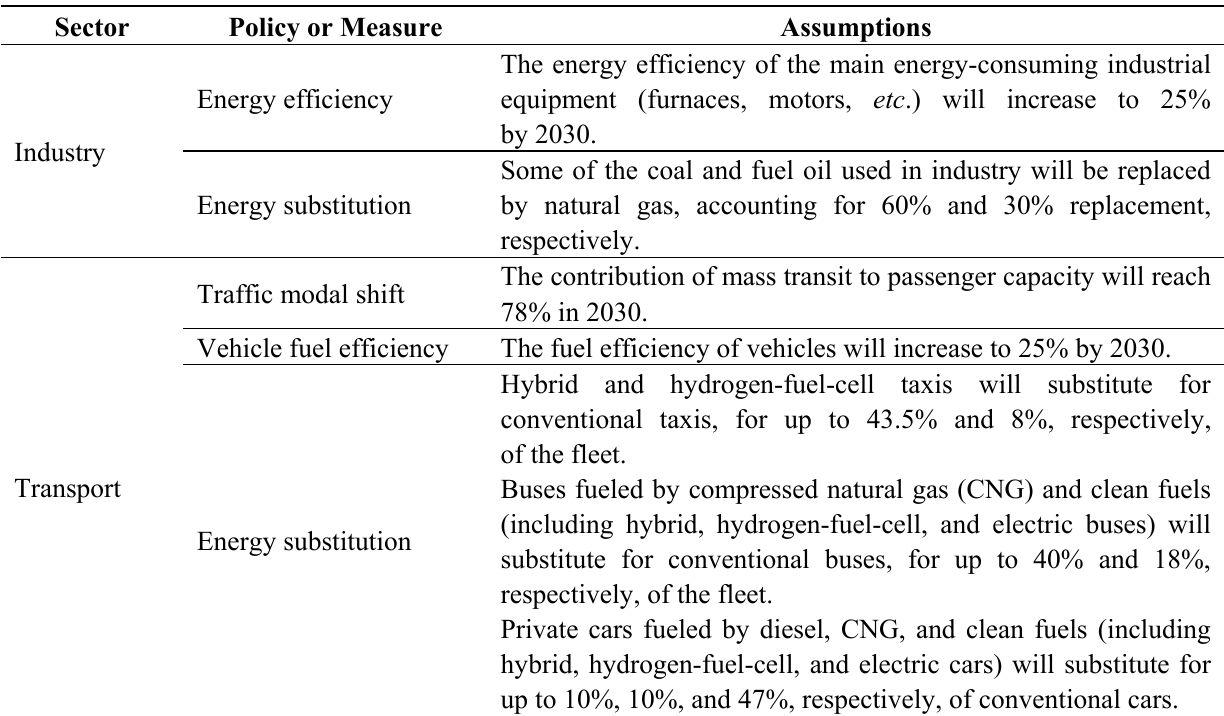
Table 3. Description of alternative policies assumed in the